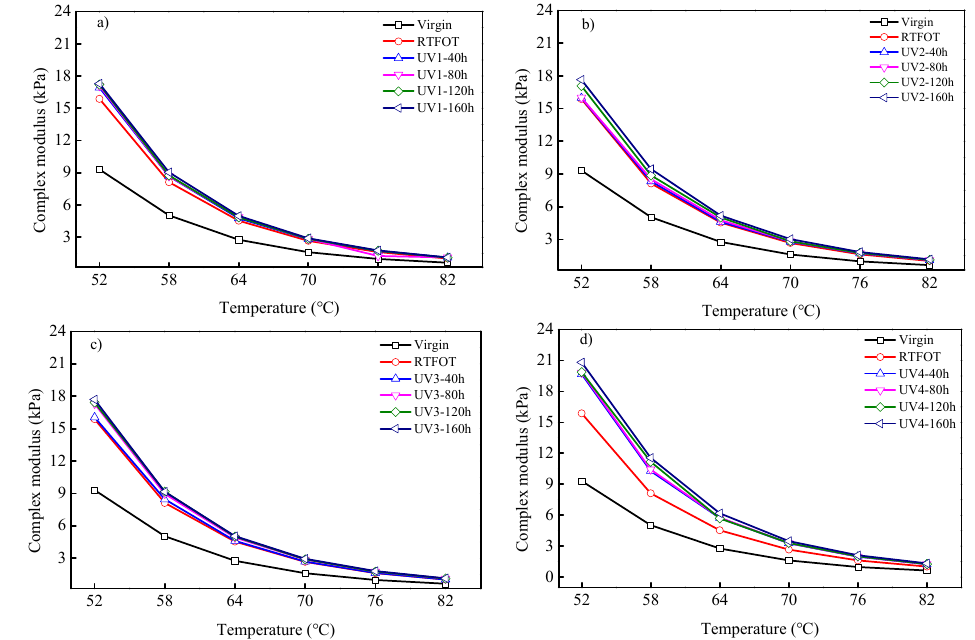
Figure 4. Complex modulus of SBS-modified asphalt binders under different UV intensities: ( a ) UV = 5 mW/cm 2 ; ( b ) UV = 10 mW/cm 2 ; ( c ) UV = 15 mW/cm 2 ; ( d ) UV = 20 mW/cm 2.